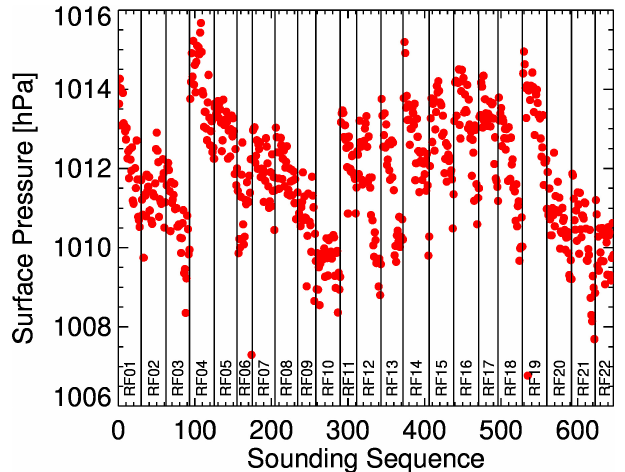
Figure 7. Surface pressure reported by all sondes. Vertical lines separate the research flights, which are indicated near the bottom.